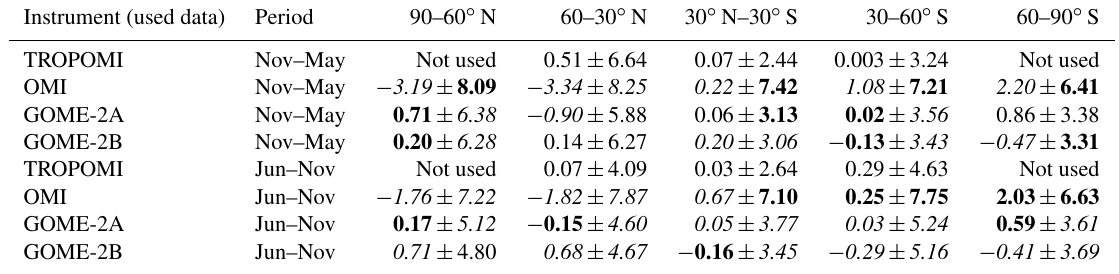
Table 4. Mean bias and standard deviations of the TCO3 retrievals against the CAMS ozone analysis in DU from the assimilation experiment (ASSIM) for the periods 26 November 2017 to 3 May 2018 and 11 June to 30 November 2018 for used data. Numbers in bold mark where the biases or standard deviations are smaller in ASSIM than in CTRL (Table 3), italic numbers mark where they are larger. Instrument (used